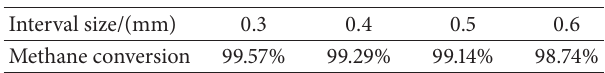
Table 2: Grid division in microchamber and methane